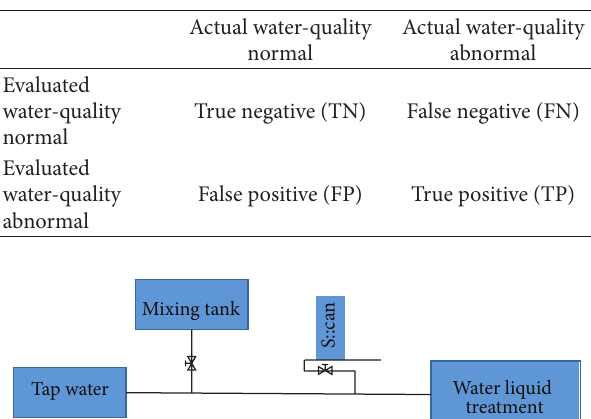
Table 2: Signs for four actual circumstances of water-quality.